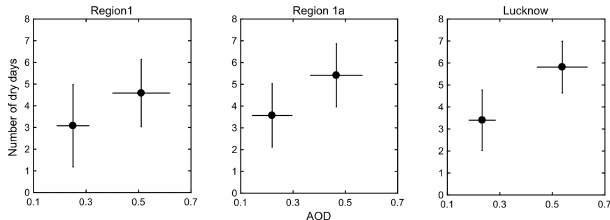
Figure 5. Sequential association between AOD cluster (16–30 July) and DDF (1–15 August) for regions 1, 1a and